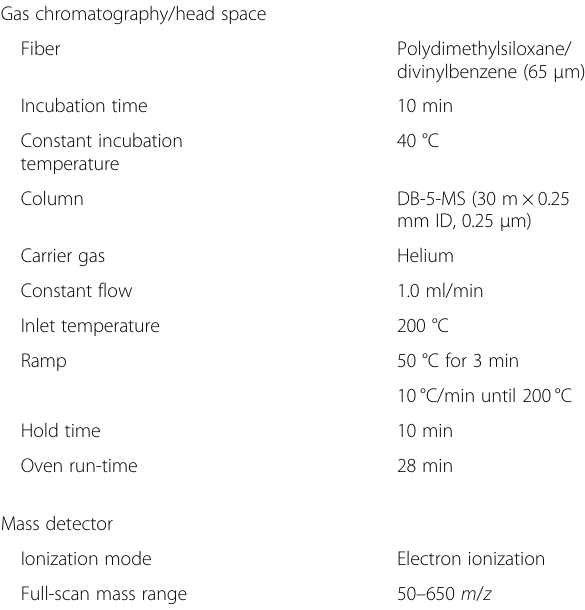
Table 1 Analytical parameters used for VOCs extraction, separation, and detection by